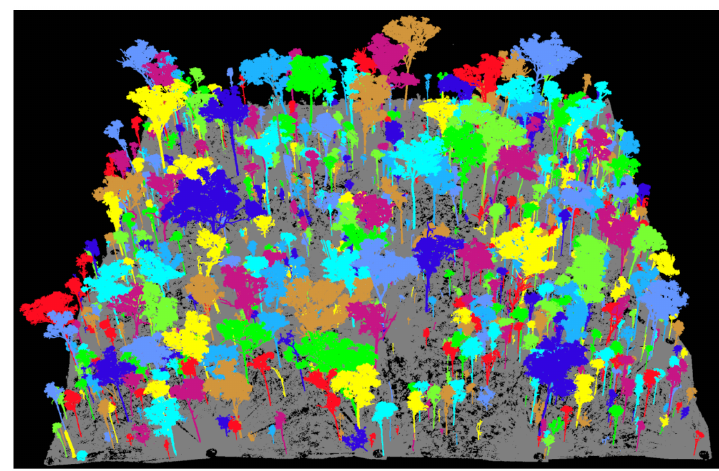
Figure 4. The study site (1 ha plot) segmented into 976 individual trees. Colours are assigned randomly; automated segmentation was followed by fine scale user